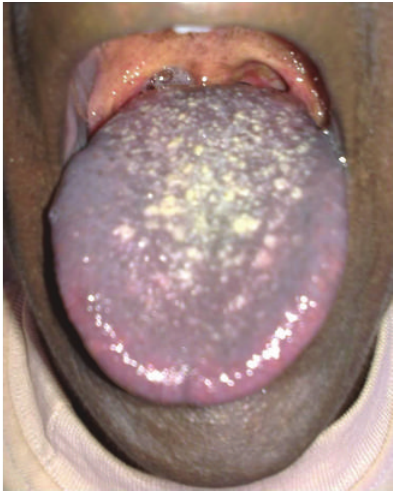
Figure 3: Generalised pigmentation seen on the dorsum of tongue with prominent lingual papillae.